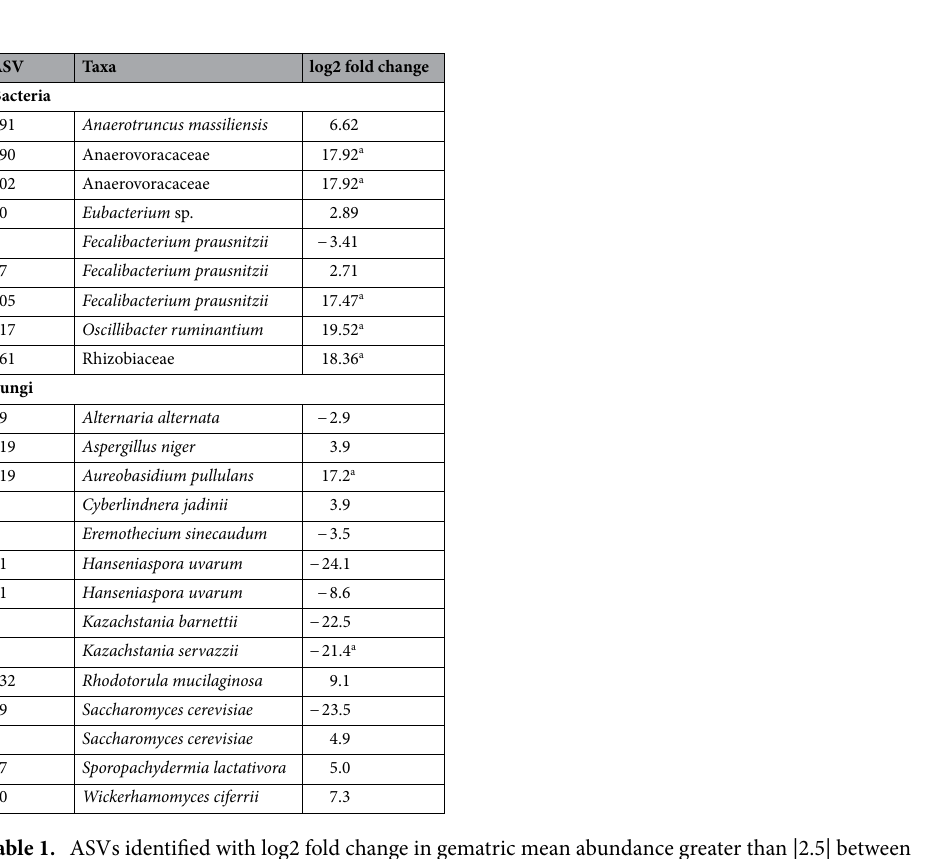
Table 1. ASVs identified with log2 fold change in gematric mean abundance greater than |2.5| between homogenized whole stool and stool aliquots. a Significant enrichment.